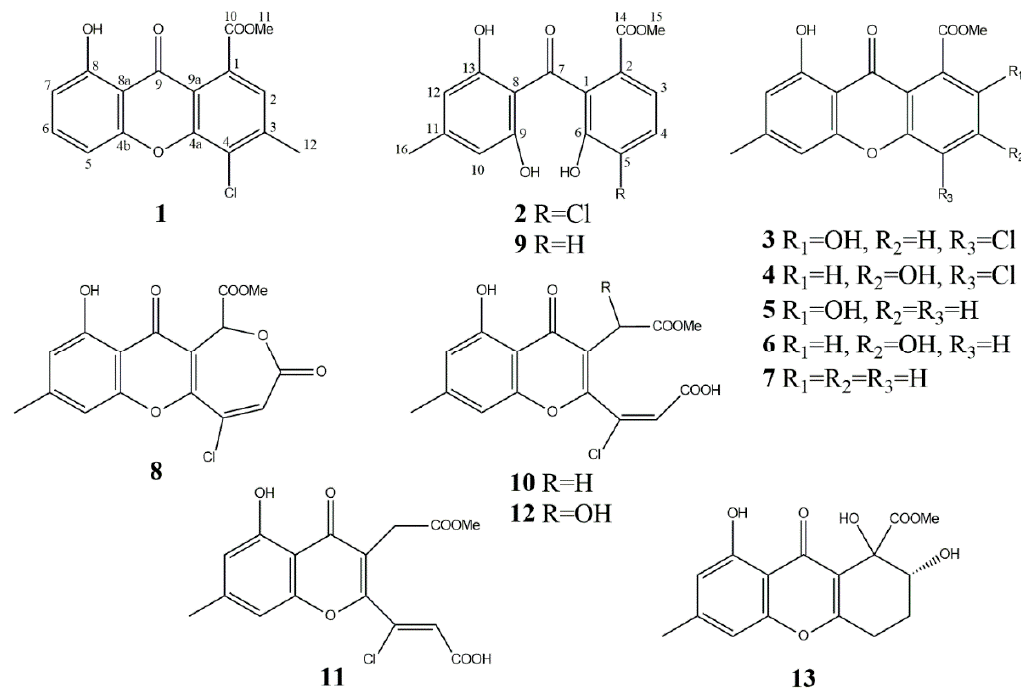
Figure 1. Structures of compounds 1 – 13 from Alternaria sonchi.